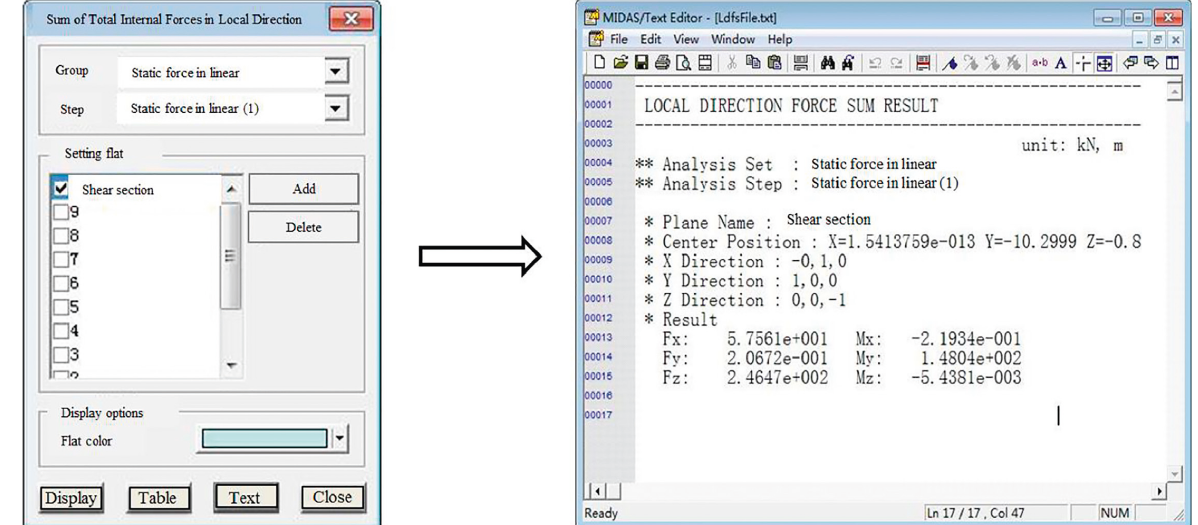
Figure 2: Selection of internal force extraction section. (a) Extraction of internal shear force V force V i in web.